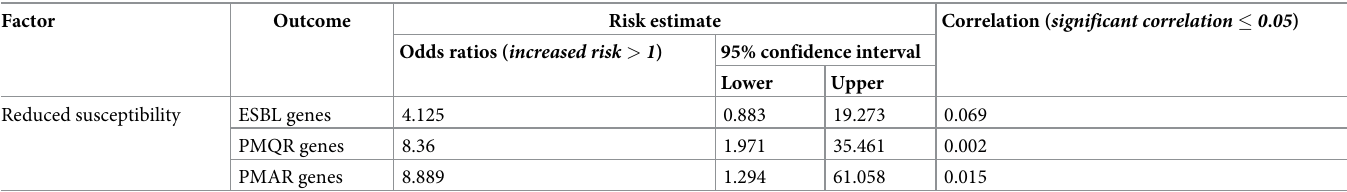
Table 6. Association between the possession of resistance genes and reduced susceptibility. Factor